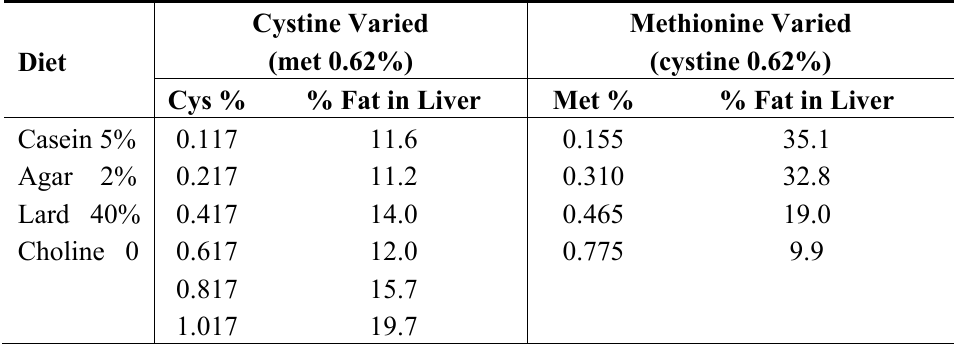
Table 6. Cystine/Methionine Ratio (from